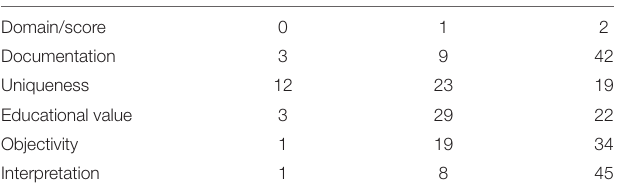
TABLE 2 | Number of case reports with different scores for the five domains of Pierson-5